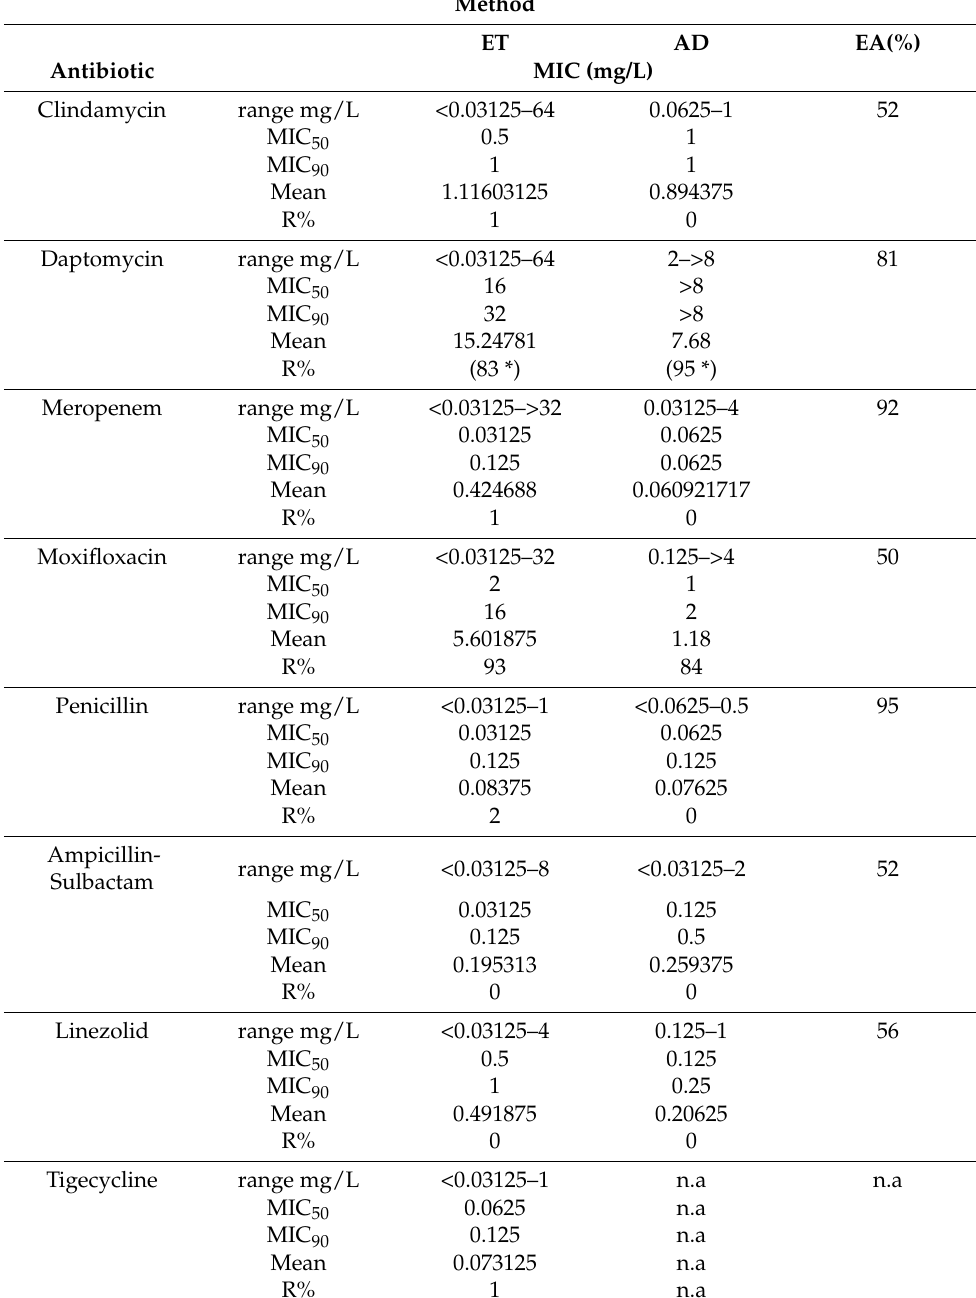
Table 2. MIC 50 , MIC 90 , geometric mean, resistance rate (R%) and EA (%) of the tested antibiotics, compared using the ET and AD